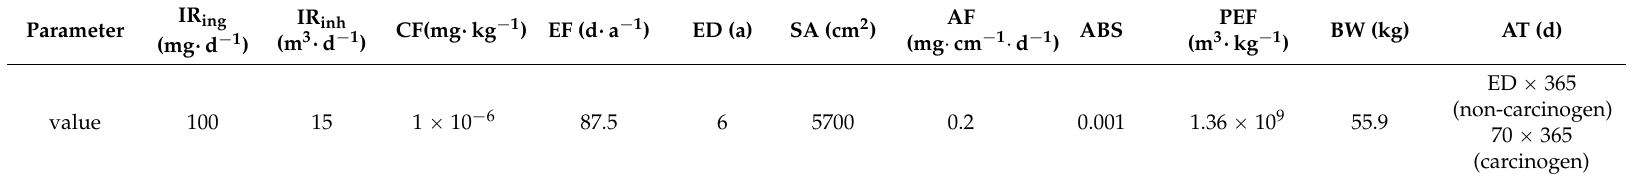
Table 2. Parameter values in average daily dose calculation models (adult).